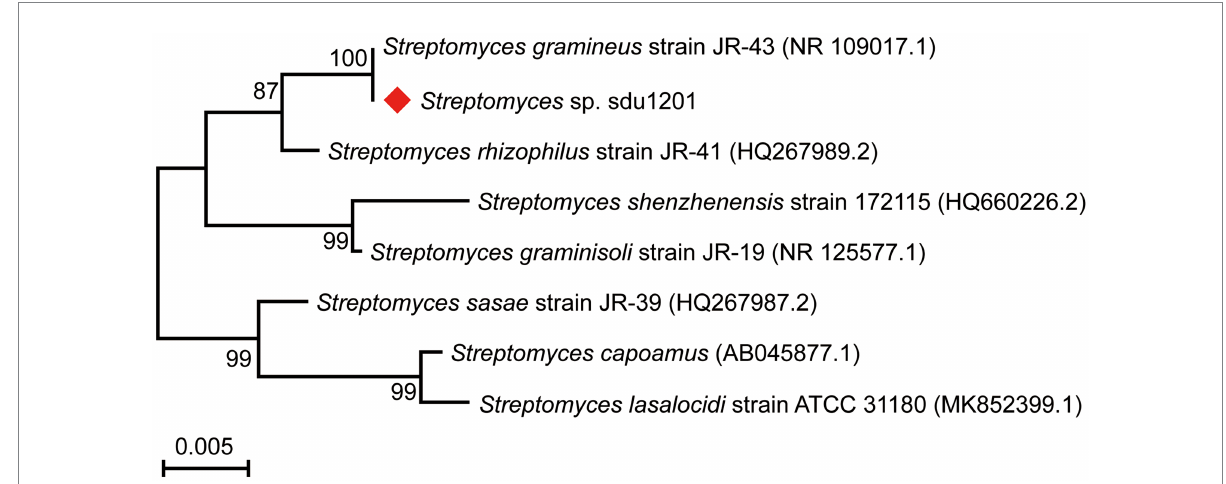
FIGURE 1 Phylogenetic tree of strain Streptomyces sp. sdu1201 based on 16S rRNA sequences by maximum-likelihood method.